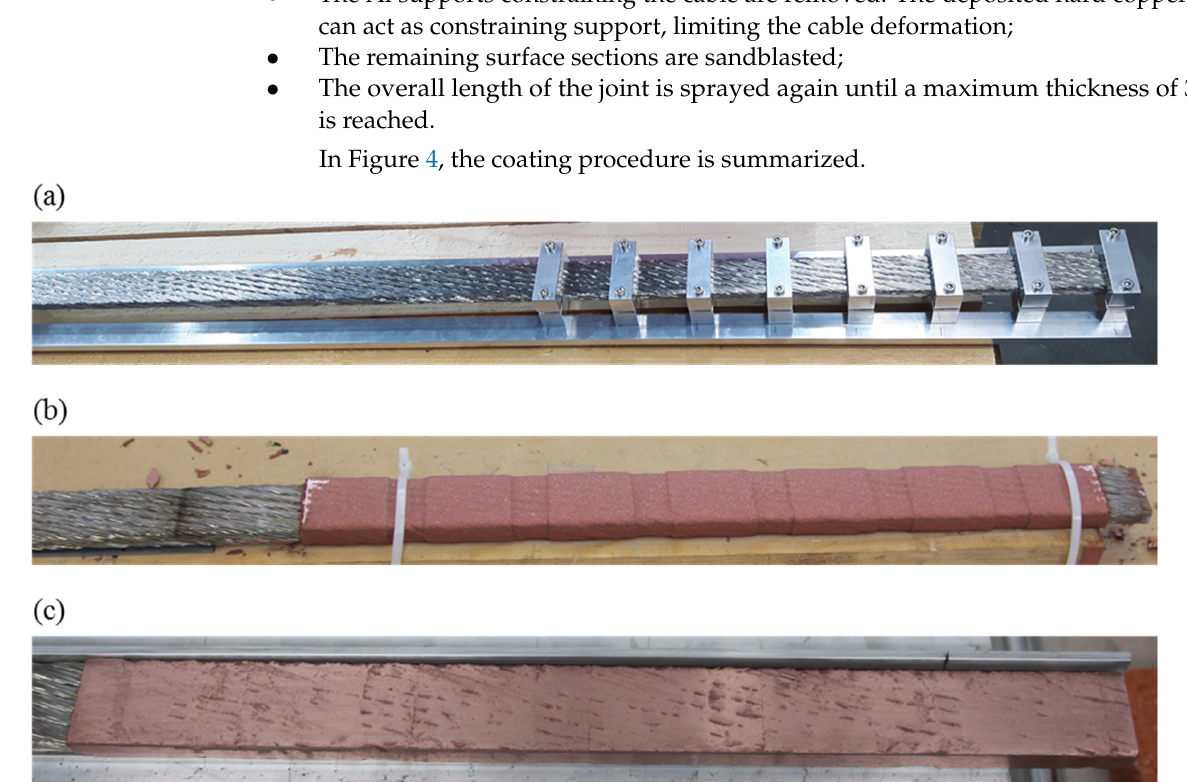
Figure 4. Superconducting cable before Cu arc spraying ( a ), after Cu deposition ( b ) and milling of the surfaces ( c ).